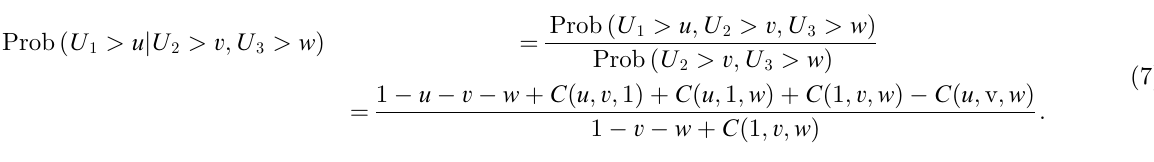
Figure 7. (a) Prob ð U 1 (cid:6) u j U 2 (cid:6) u ; U 3 (cid:6) u Þ from equations (3) to (4), with d = 1, 2, 4, 10, 20. (b) Prob ð U 1 > u j U 2 > u ; U 3 > u Þ from equations (3) to (7), with d = 1, 1.5, 2, 2.5,